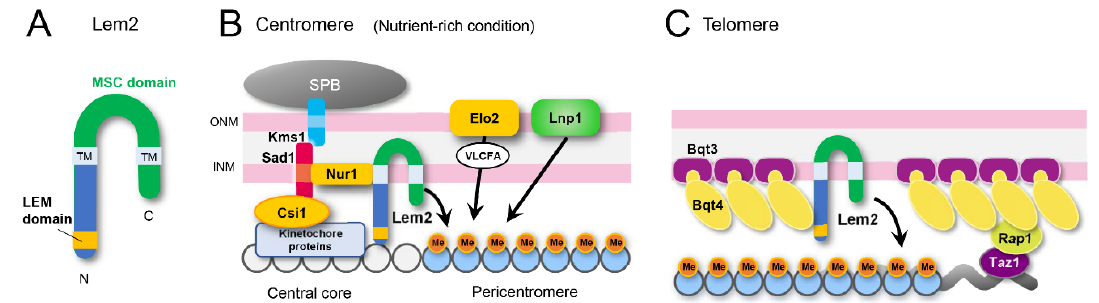
Figure 6. Lem2 for heterochromatin formation. ( A ) Molecular domains of Lem2. TM, transmembrane domain. ( B ) Lem2 on pericentromeric heterochromatin. White circles represent chromatin at the central core of the centromere and blue circles represent chromatin at the pericentromeric heterochromatin. Lem2 is localized at the central core and promote heterochromatin formation at the pericentromeric regions. Elo2 and Lnp1 compensate Lem2 functions. VLCFA, very-long-chain fatty acid. ( C ) Lem2 on sub-telomeric heterochromatin. Lem2 is localized to the NE through interaction with Bqt4, and promotes heterochromatin formation at the sub-telomeric regions attached to the NE through an interaction between Rap1 and Bqt4.